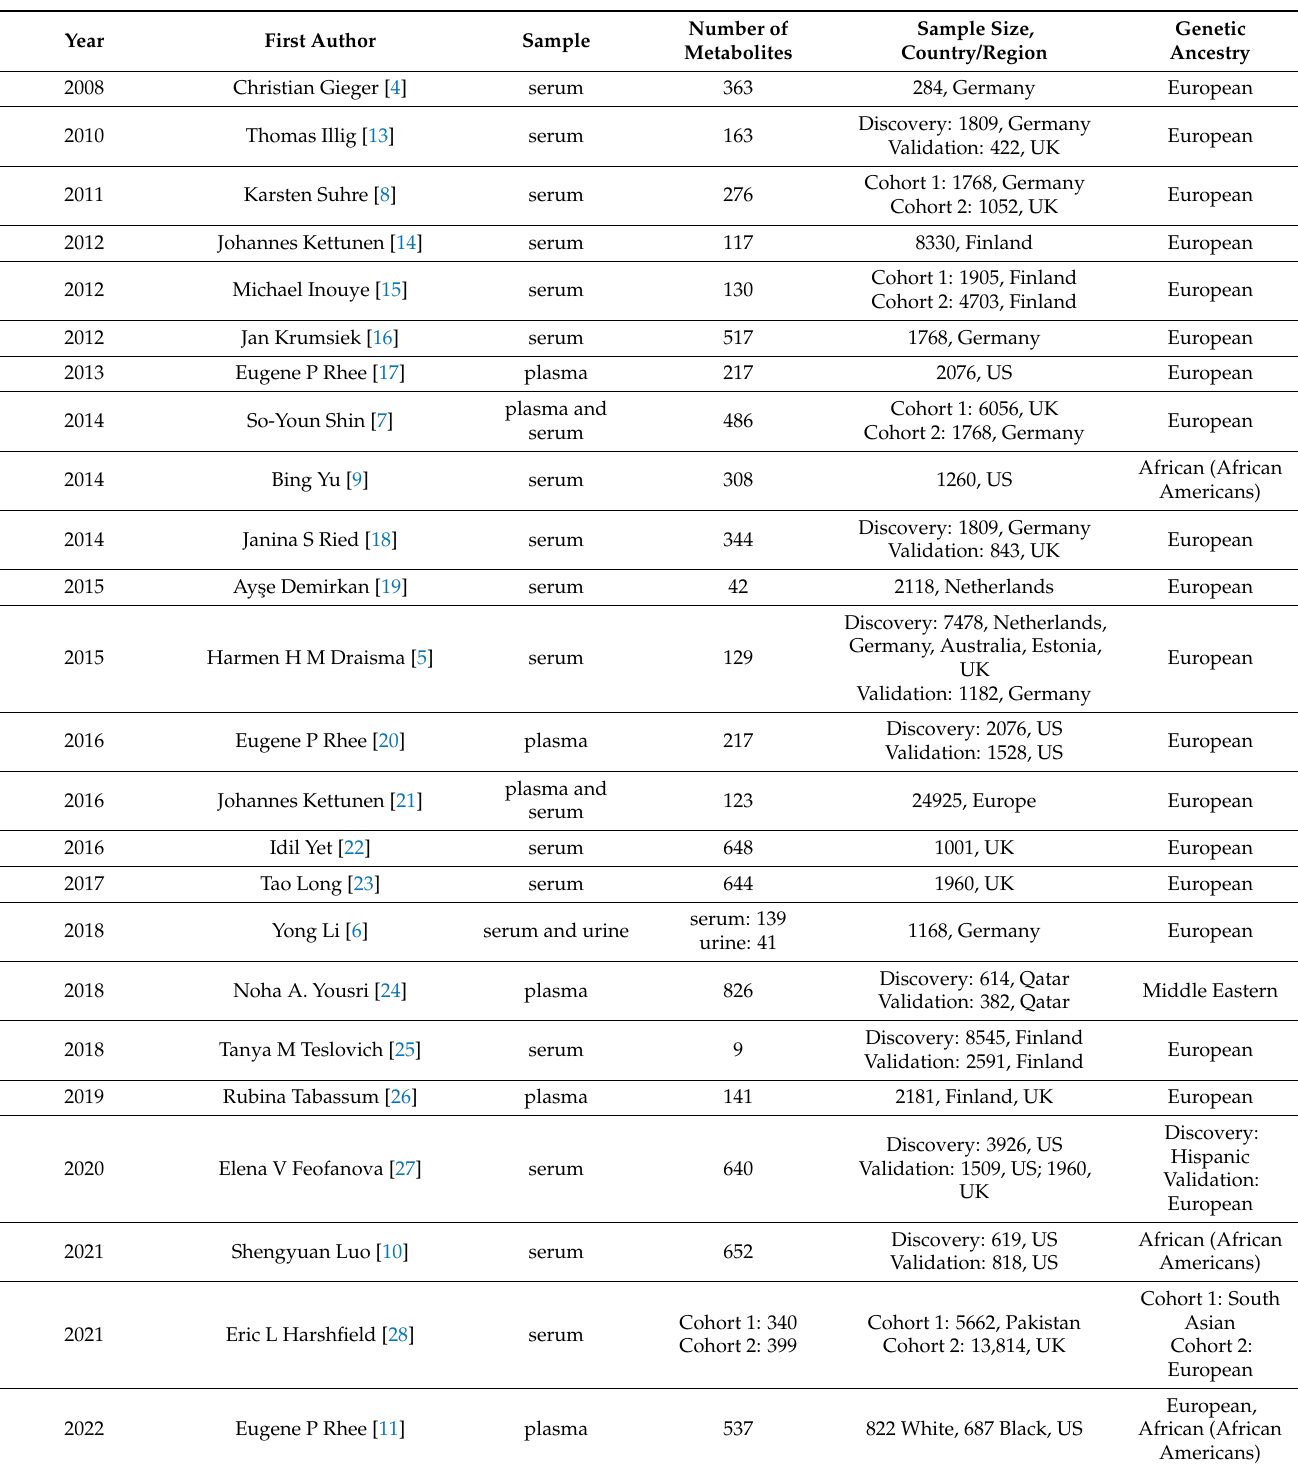
Table 2. Articles selected for the candidate gene–metabolite